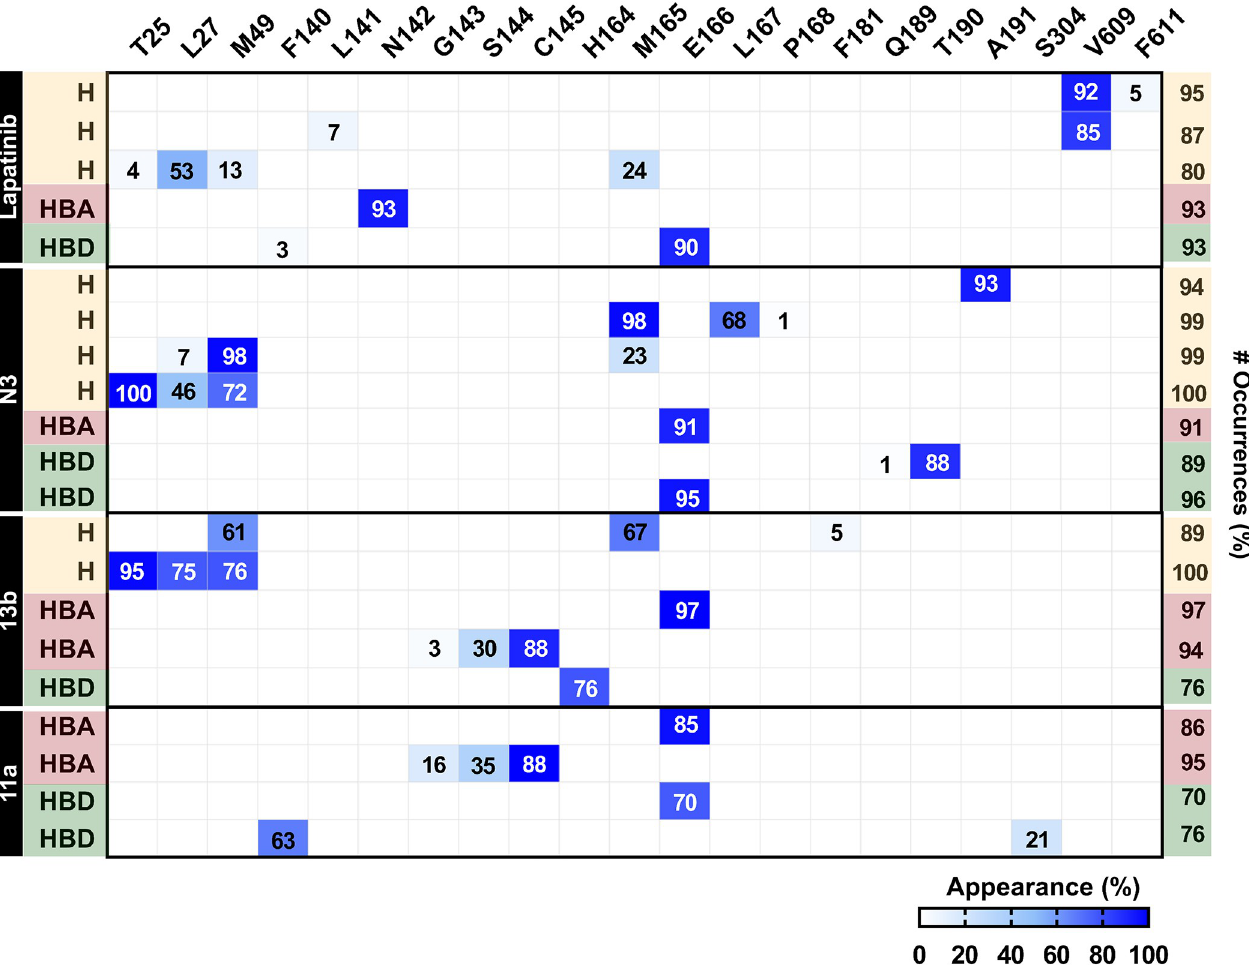
Fig 9. Interaction map of four inhibitors against SAR-CoV-2 3CL pro derived from 401–500 ns MD trajectories for lapatinib 81–100 ns, and MD trajectories for peptidomimetic inhibitors N3, 13b, and 11a. The abbreviations of H, HBA, and HBD represent the pharmacophore features of hydrophobic interaction, hydrogen bond acceptor, and hydrogen bond donor properties. The numbers in the blue box are the percentage of appearance in each interaction per residue.